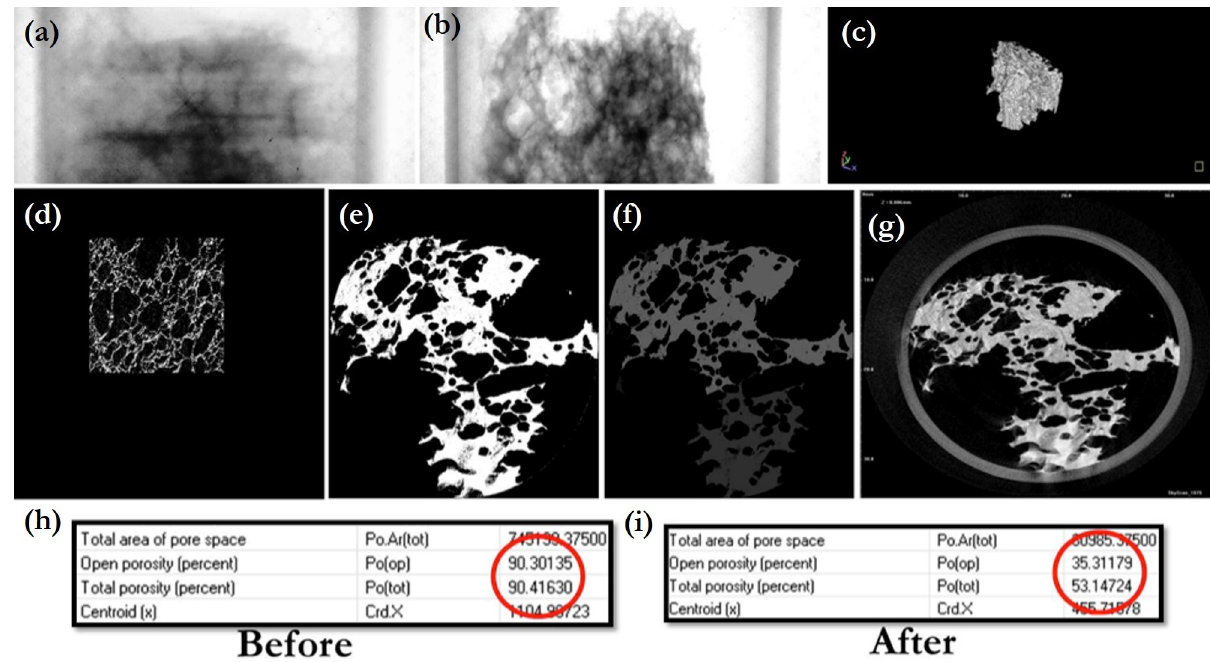
Fig 4. μ -CT investigations of the pore network: Sequence of operations (segmentation, filtration and thresholding) to resolve the different phases in the clogged and unclogged samples. A 3x reduction in porosity has been highlighted.